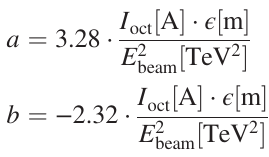
FIG. 4. Stability diagrams from octupoles powered with oppo- site polarities.